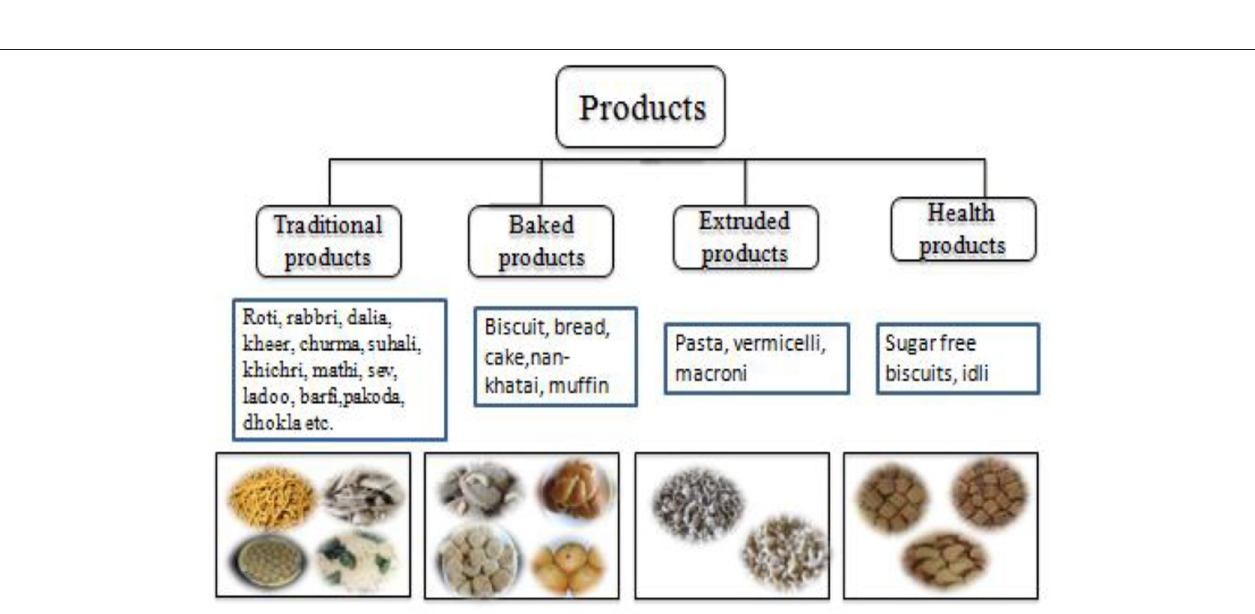
FIGURE 5 | Rancidity matrix to measure rancidity in the pearl millet flour (Adapted from: Goswami et al., 2020).